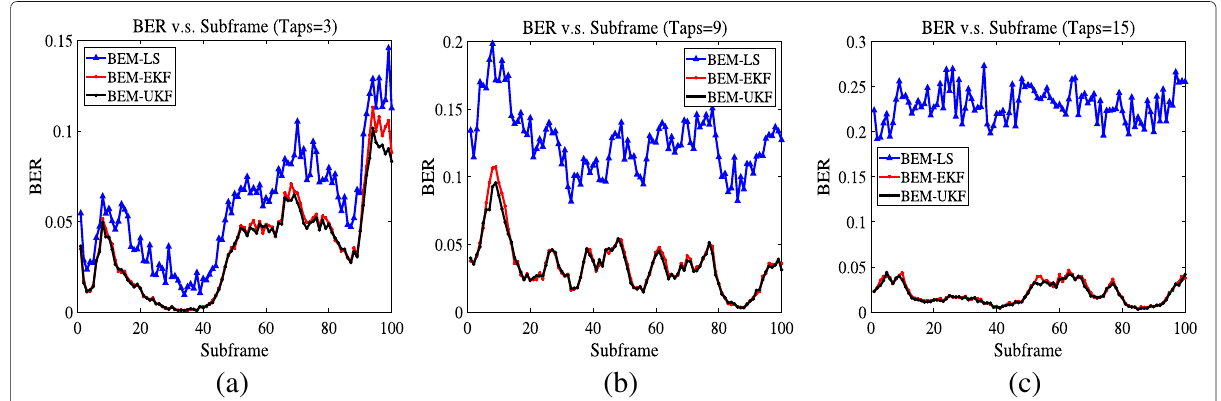
Fig. 9 BER for channel estimation methods in different taps and SNR environments. BER change of 100 consecutive subframes in different multi-path environments where the SNR = 10 dB